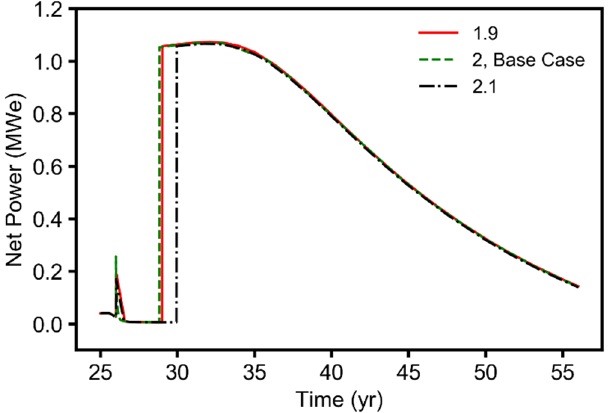
Figure A5. Simulation results (time-series plots) for the relative permeability (van Genuchten) pa- rameter, showing the geothermal net power generated during the EGR and CPG stages (25–55 years).